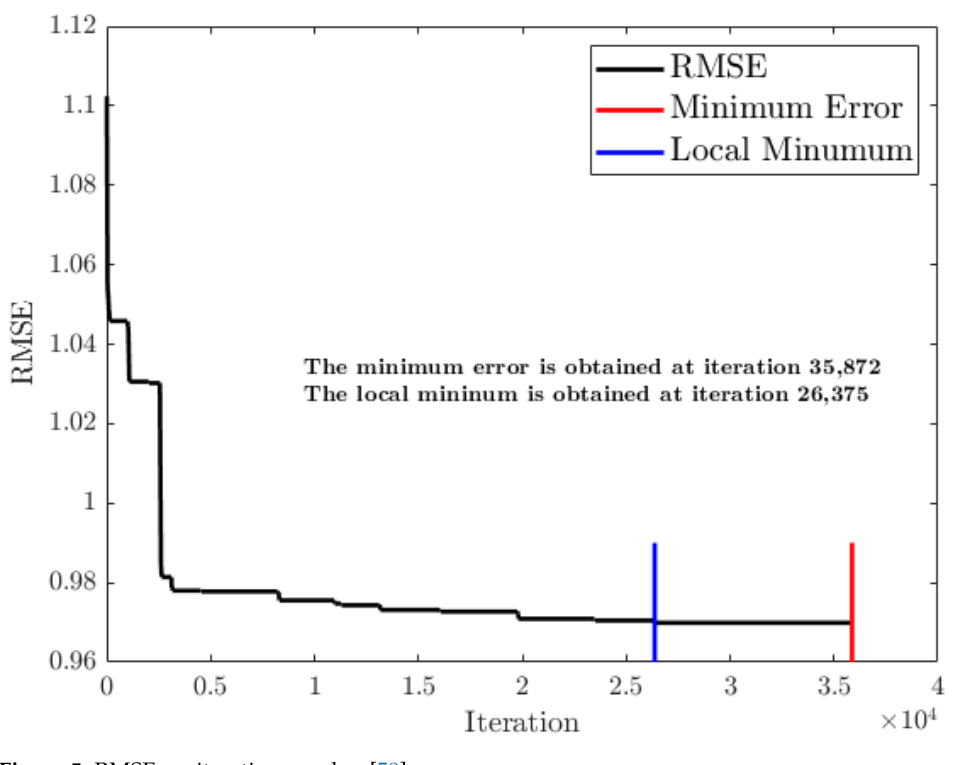
Figure 5. RMSE vs. iteration number [59]. Table 9. Attribute weights after GA [59] .